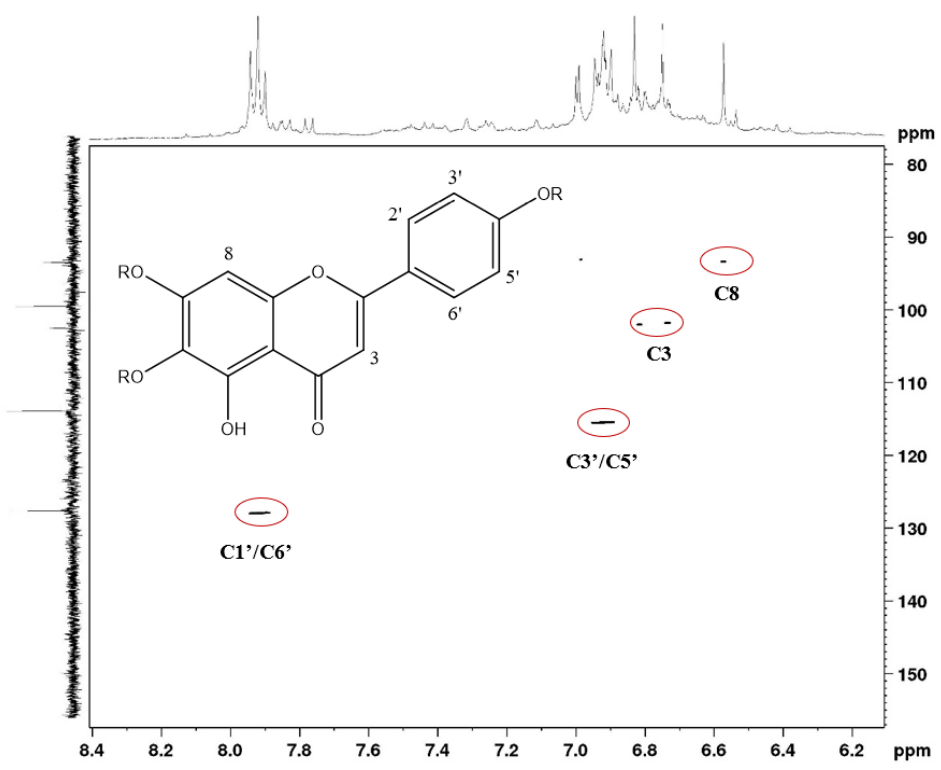
Figure 13. HSCQ contour map of flavonoids present in the ethanolic extract of F. chica leaves ( 1 H NMR—400 Hz, DMSO-d6, δ ).